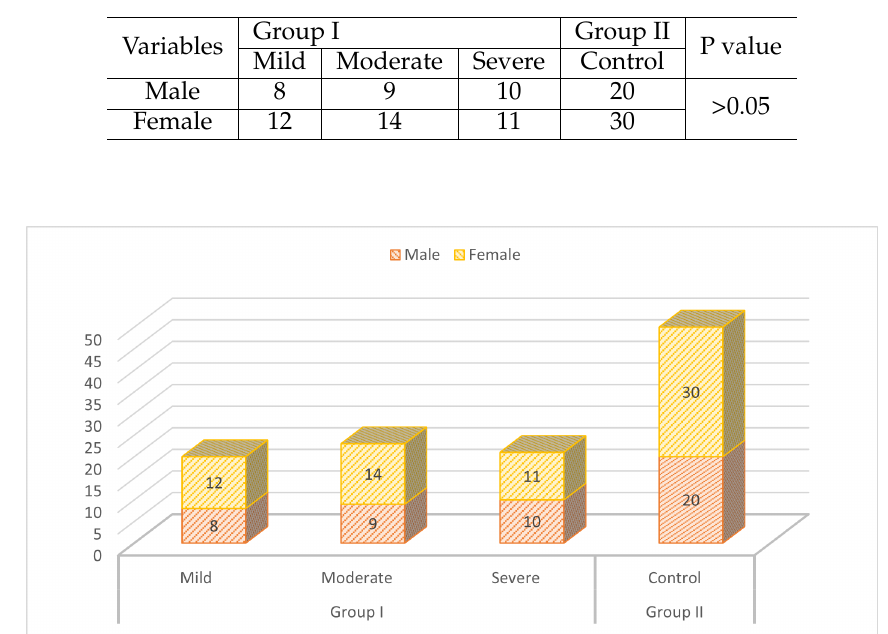
Figure 1. Characteristics of subjects